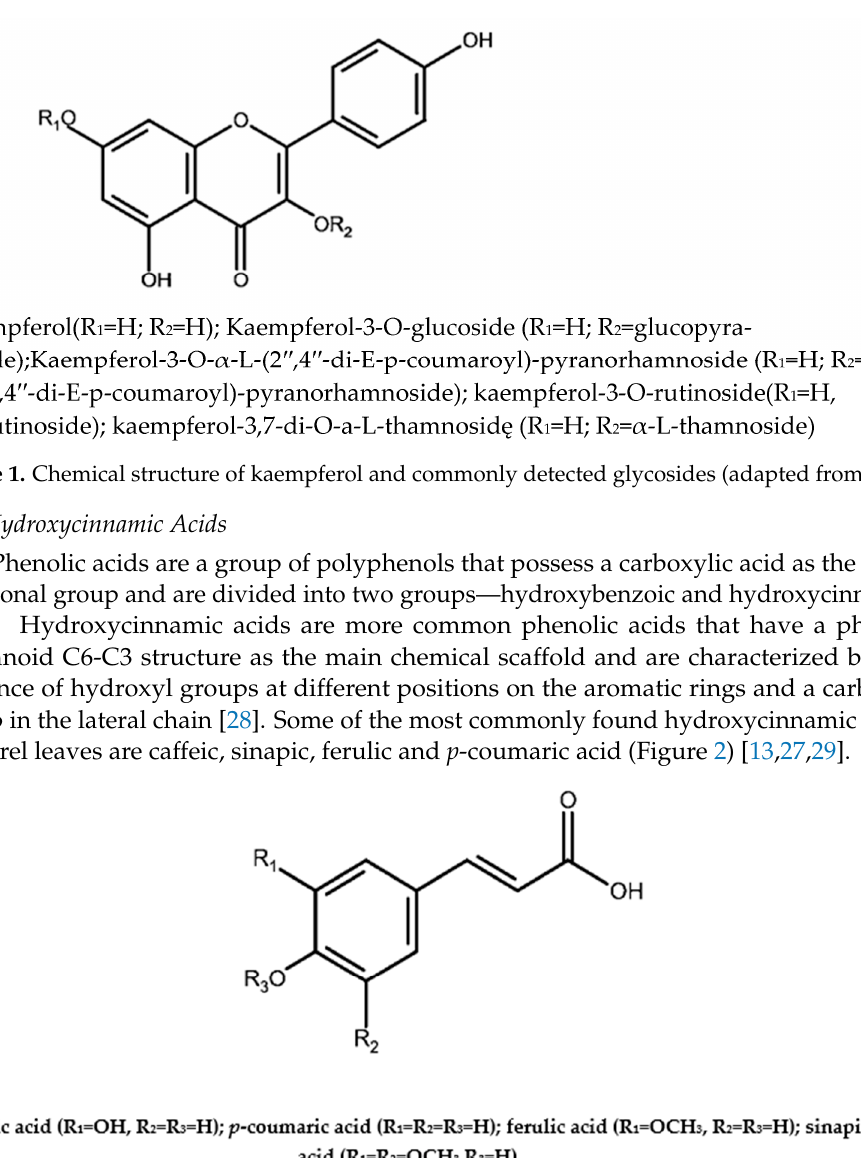
Figure 2. Chemical structure of hydroxycinnamic acids commonly detected in laurel leaves (adapted from [13,27]).